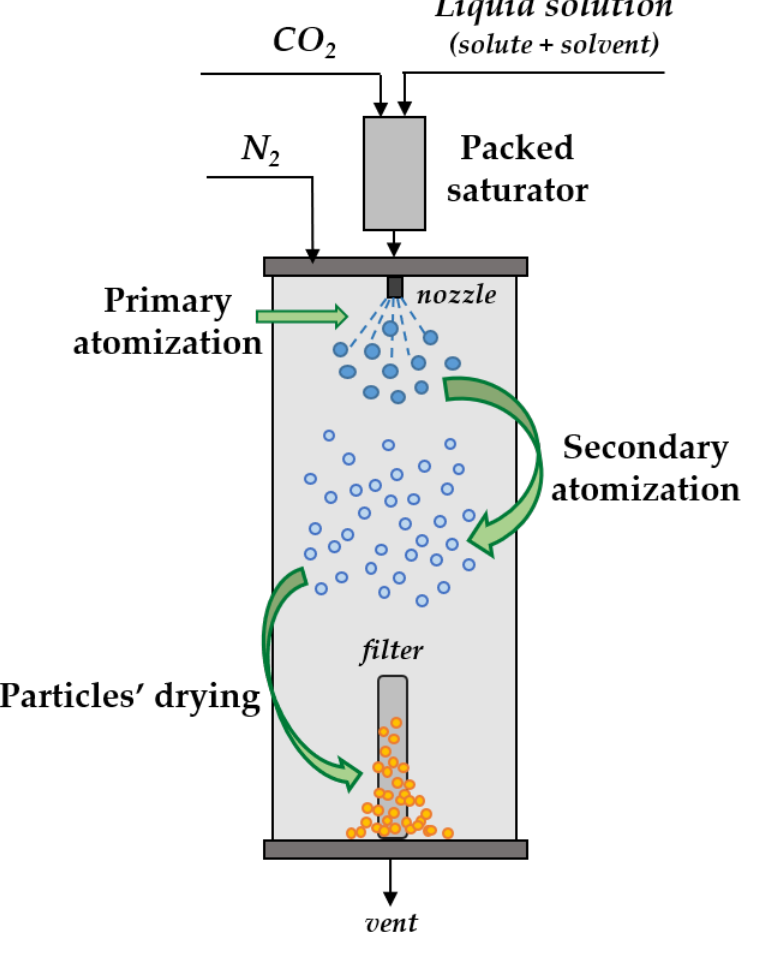
Figure 7. A sketch of supercritical assisted atomization (SAA).